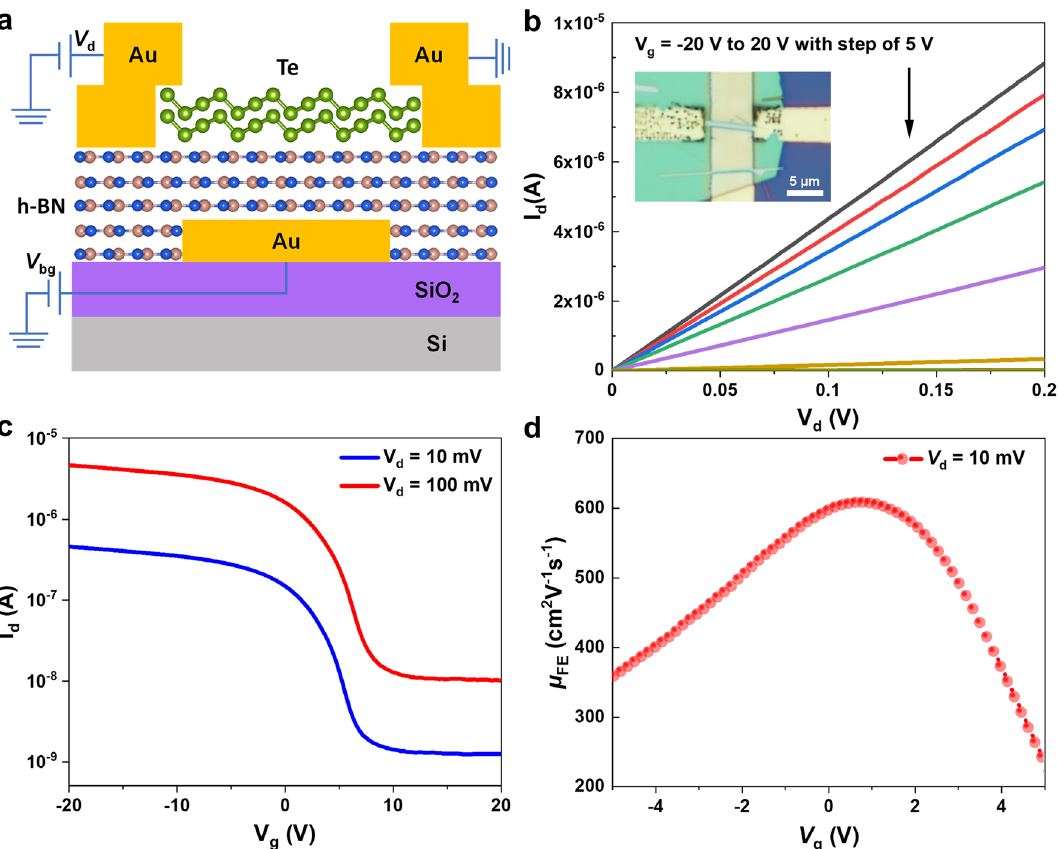
Fig. 4 a Schematic illustration of local bottom‑gate Te FET by using h‑BN as dielectric layer in a cross‑sectional view. b Output curves of a typical Te FET. The inset shows the optical image of the measured Te FET with local bottom‑gate structure. c Transfer curves of the same Te FET device under different bias measured at room temperature. d Field‑effect mobility of Te transistor extracted from the transfer curve under the bias of V d = 10 mV in panel